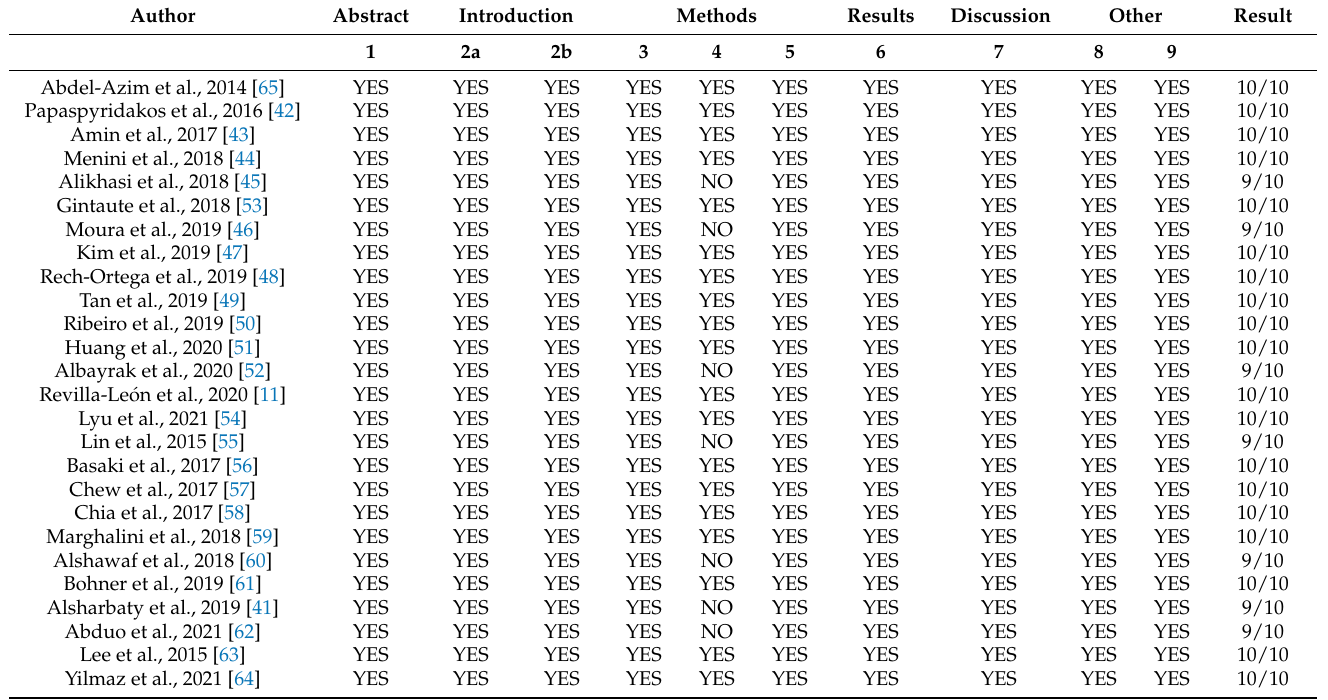
Table A2. Results of the quality assessment of selected articles using the modified CONSORT checklist for in vitro studies comparing different dental implant impression